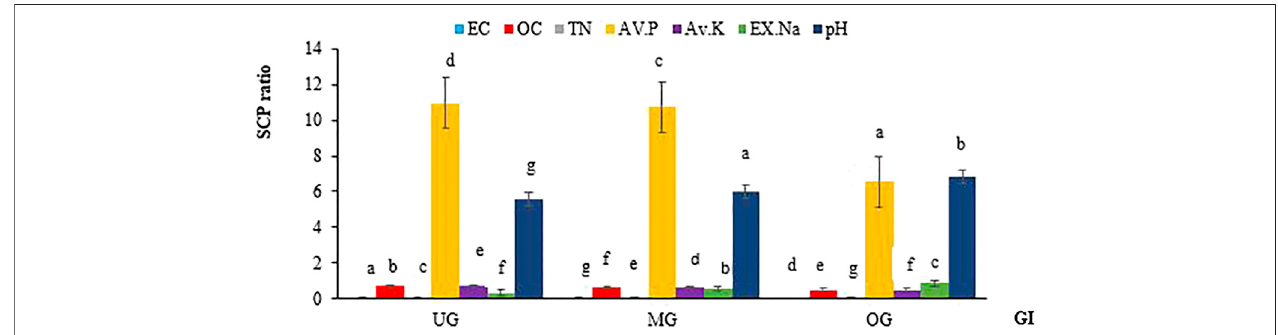
FIGURE 4 | Mean ± SE soil chemical properties abundance across grazing intensity. Bars with different letters are signi fi cantly different for each grazing intensity site. SCP, soil chemical properties; GI, grazing intensity; NG, non-grazing; MG, moderately grazing; OG, overgrazing.